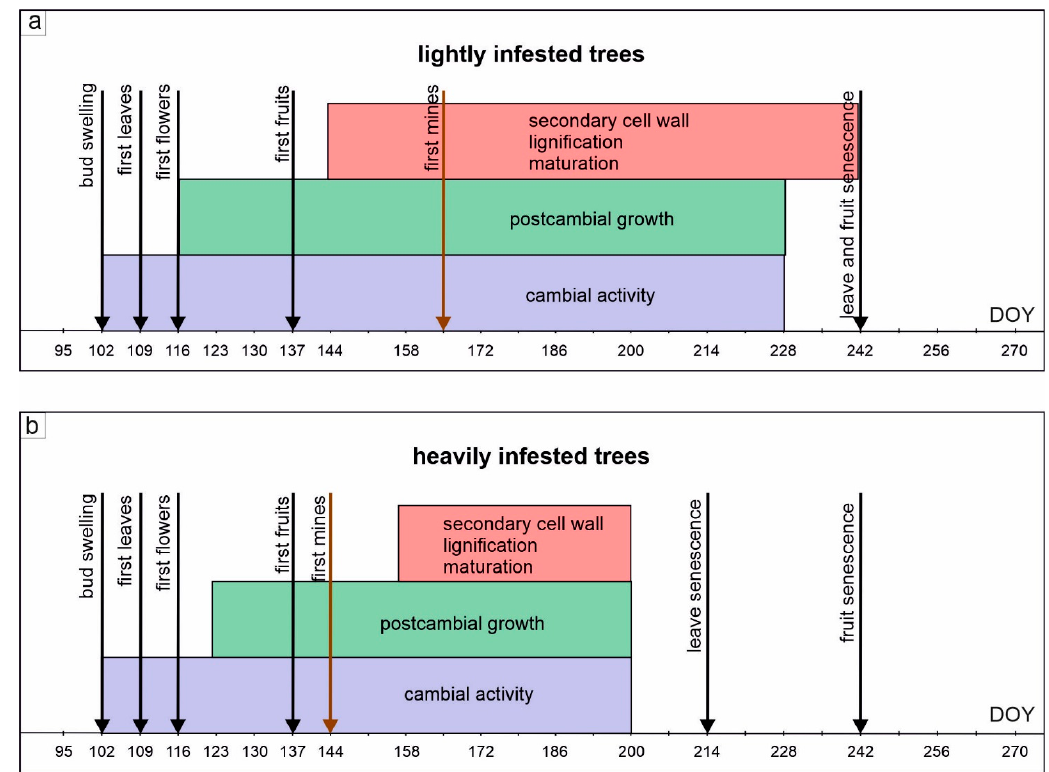
Figure 4. The duration of cambium activity and of successive stages of differentiation of secondary xylem cells in lightly ( a ) and heavily infested ( b ) trees of Aesculus hippocastanum . The length of the rectangles indicates the mean onset and cessation of the analysed stages during the year. The vertical lines indicate the dates when the successive phenological stages and symptoms of horse chestnut infestation was observed. In HIT, the duration of cambium activity was shortened by about one month, which resulted in the shortening of the successive stages of wood differentiation. This shortening can be attributable to the difference in the level of infestation of the previous years; DOY—day of the year.